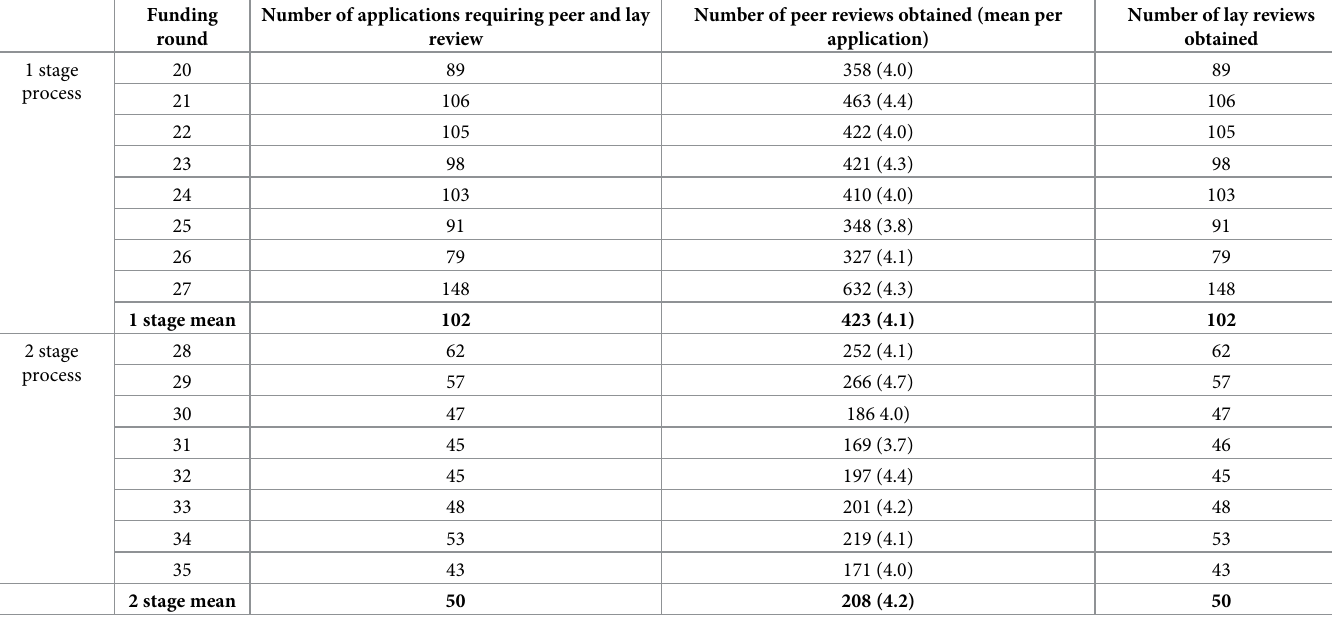
Table 3. Number of reviewers required and obtained (external peer and lay reviewers).